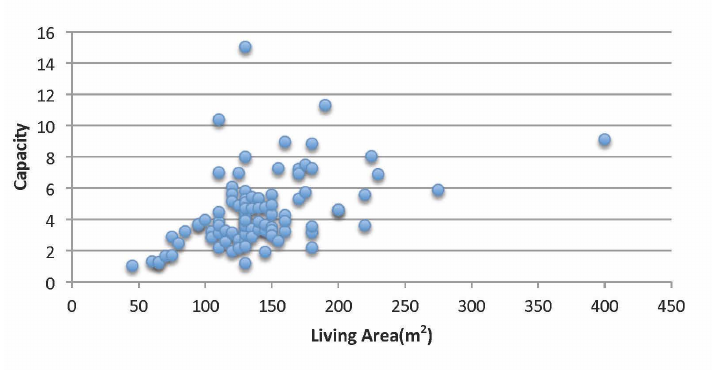
Figure 7. Relation between size of the house and estimated value for thermal